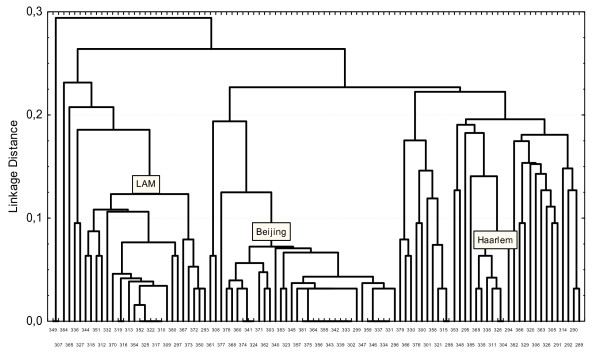
Clustering dendrogram of 98 isolates of the M. tuberculosis complex isolated in Kharkov Region constructed from results of VNTR-typing. The abscissa axis is number of isolate. The ordinate axis is a linkage distance.